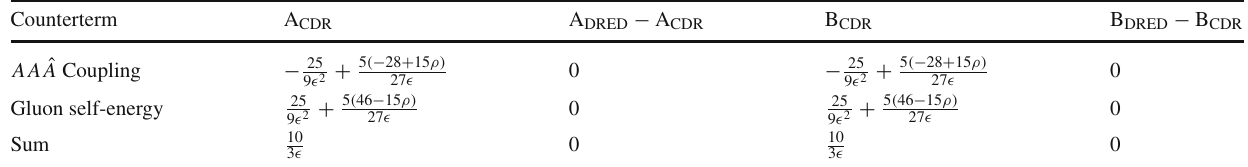
Table 13 Counterterms results for pure Yang–Mills using CDR and DRED, where ρ = γ E − ln 4 π + ln ( p 2 /μ 2